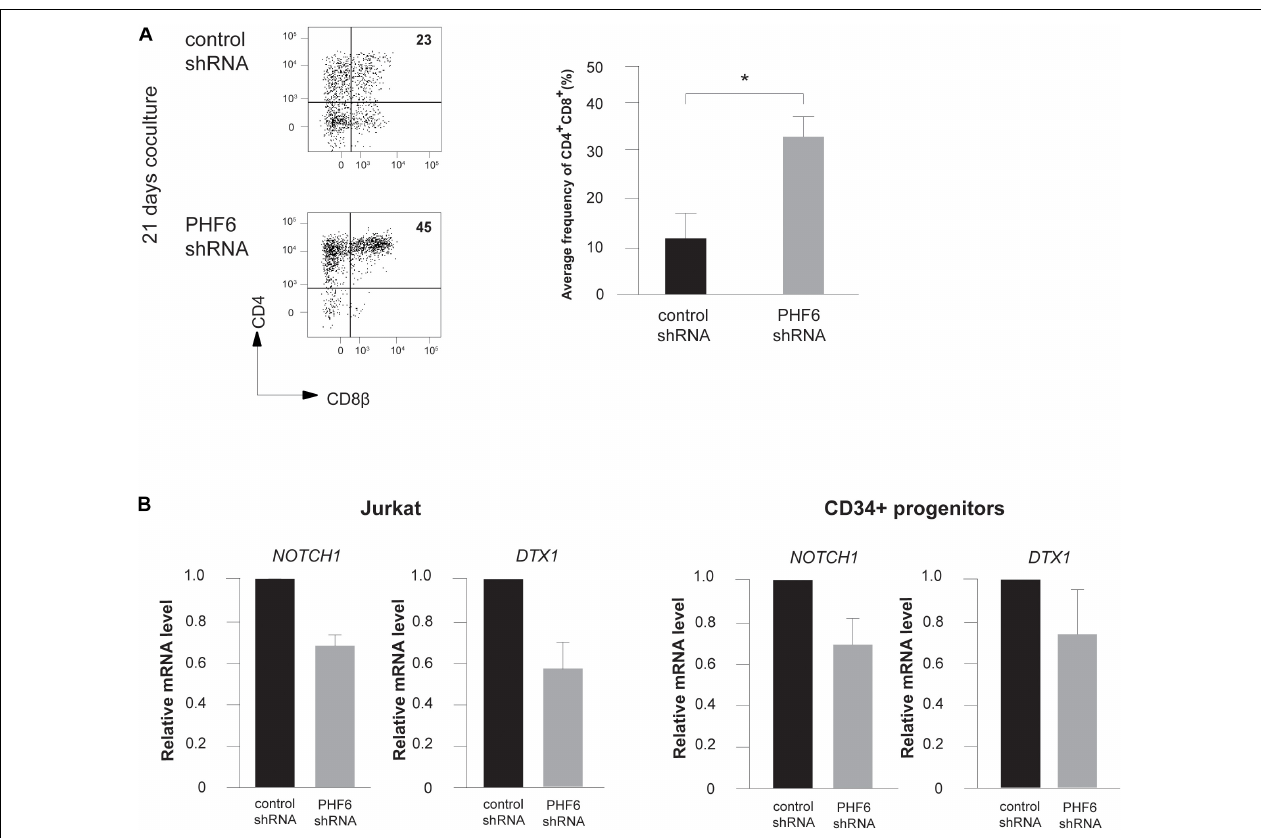
FIGURE 4 | PHF6 modulates Notch1 expression and its downstream signaling activity. (A) ( left ) Flow cytometry analysis of control and PHF6 shRNA transduced CD34 + thymocytes in OP9-DLL1 cocultures in the presence of IL7, SCF and FLT3L, showing the development of CD4 + CD8 β + DP thymocytes after 21 days of coculture. ( right ) Bar plot showing the frequency of CD4 + CD8 β + DP thymocytes, generated in the corresponding cultures. Data shows the average of 4 independent experiments and errors bars show SEM. * P < 0.05 (paired t -test) (B) Normalized NOTCH1 and DTX1 expression in Jurkat cells (left) and CB-derived CD34 + HPCs (right) following control or PHF6 shRNA transduction as indicated. Data shows the average expression in 3 independent samples and error bars indicate